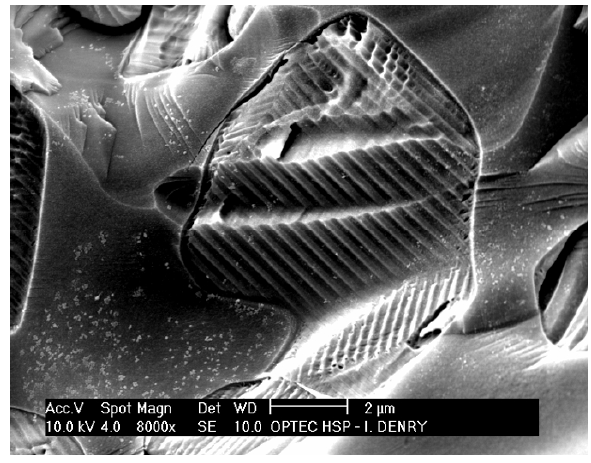
Figure 1. Leucite crystal in a veneering dental ceramic (fractured